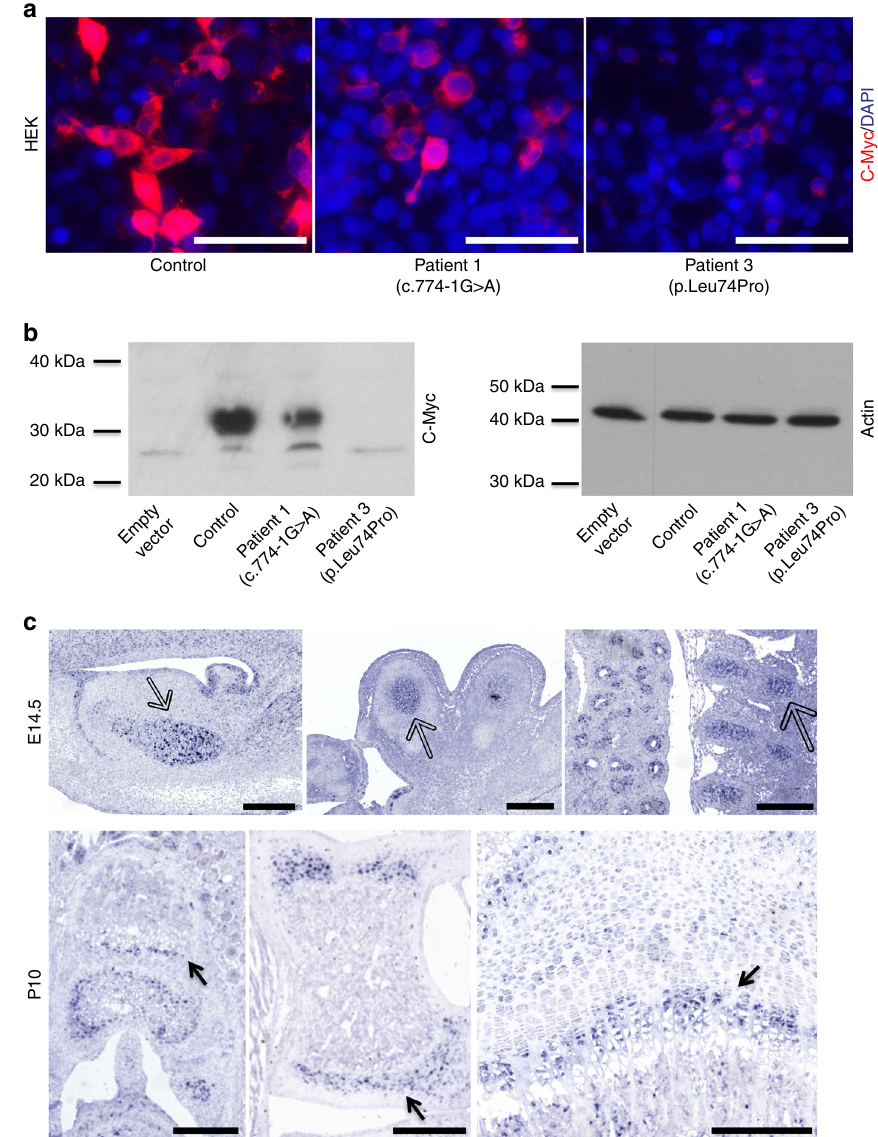
Fig. 2 SLC10A7 mutation consequences and Slc10a7 tissular expression. a , b Characterization of wild-type and mutant SLC10A7 proteins. HEK293F cells were transfected with plasmids encoding c-myc tagged wild-type SLC10A7 proteins or c-myc-tagged mutant SLC10A7 proteins from two different patients (Patient 1 and Patient 3). a Cells were immunostained with anti-c-Myc antibody (red) and nuclei were counterstained with DAPI (blue). Scale bars = 20 μ m. The images are representative of three independent experiments. b Total cell lysates were analysed by western blotting using c-Myc antibody. Anti- actin was used as a loading control. The western blot images are cropped from gels that were provided for review as Supplementary Fig. 1d. c In situ hybridization analysis of Slc10a7 mRNA expression in E14.5 mouse embryos and P10 mouse tissues. The blue staining indicates sites of RNA hybridization. At E14.5, empty arrows indicate speci fi c staining in cartilaginous tissues: Meckel cartilage (left panel) in the mandible and phalanges in the digits (central panel) and vertebrae (right panel). Note the positive staining in the lung on the right panel. At P10, fi lled arrows indicate speci fi c staining in the hypertrophic zone of the growth plate in the digits (left panel), in the tarsals (central panel) and in the epiphysis of the humerus (right panel). Scale bars = 250 μ